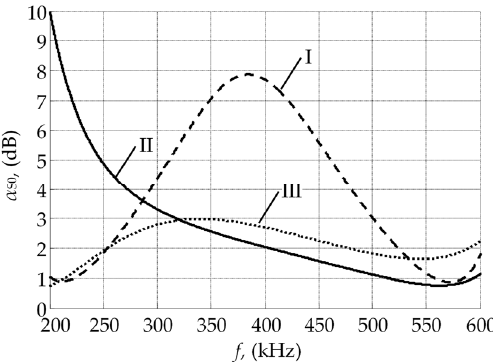
Figure 8. The transmission losses α S0 ( f ) of the S 0 wave mode at different lap joint bonding conditions in the case: I: plates are connected only at the weld seam position, II: partially bonded plates, III: fully bonded plates.